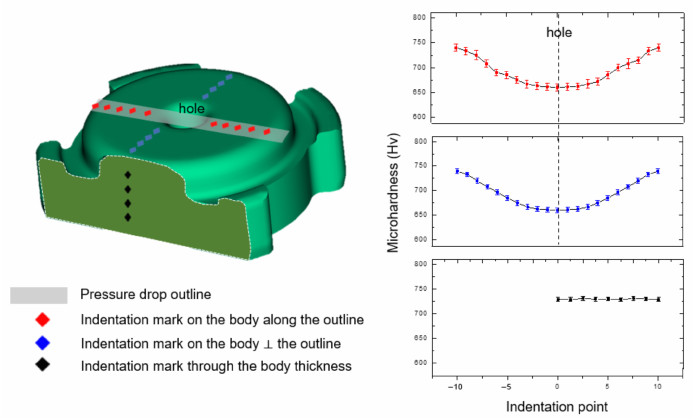
Figure 8. Vickers hardness analysis along the three traces. Indentation along the pressure drop outline (red), perpendicular to pressure drop outline (blue), and perpendicular to previous two traces